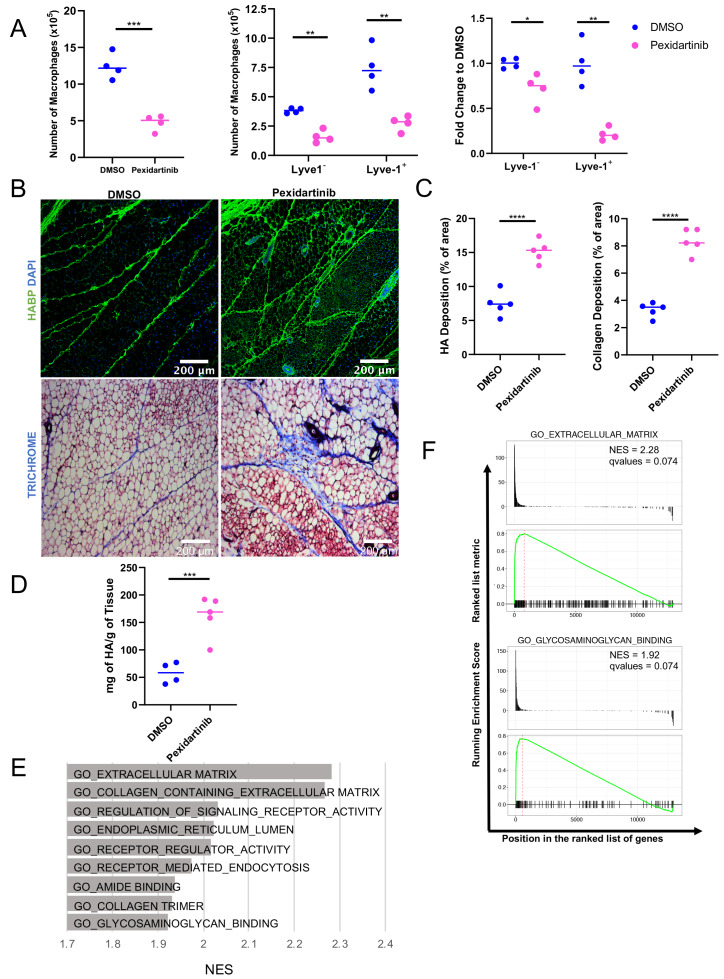
Macrophage depletion impacts ECM in the stroma.(A) 5-week-old female mice were treated with pexidartinib for 2 weeks and mammary glands were harvested for analysis of macrophages for CD45+CD11b+F4/80+ by flow cytometry. Flow cytometry demonstrated depletion of CD45+CD11b+F4/80+Lyve-1– and CD45+CD11b+F4/80+Lyve-1+ cells in the mammary gland following pexidartinib treatment. Quantification of total cell counts and fold-change depletion are shown. Total Macrophages Number DMSO vs pexidartinib, p=0.0007; Lyve1– Macrophages Number DMSO vs pexidartinib, p=0.0015; Lyve1+ Macrophages Number DMSO vs pexidartinib, p=0.0095; Lyve1– Fold Change DMSO vs pexidartinib, p=0.037; Lyve1+ Fold Change DMSO vs pexidartinib, p=0.0052. These data demonstrate one representative experiment, experiments were repeated three times with similar results, n = 4 mice per treatment group. (B) Mammary glands from mice treated with either pexidartinib or solvent control were stained for HA (HABP, green) or with trichrome to visualize collagen-containing ECM (collagen, blue). (C) Quantification of HABP and collagen staining. Between 3 and 6 images/sample were analyzed for HABP and collagen staining, n = 5 per treatment group. Three replicates were used for HABP analysis and one replicate was done for collagen analysis. HA deposition (% of area) DMSO vs pexidartinib, p<0.0001 (pooled) and collagen deposition (% of area) DMSO vs pexidartinib, p<0.0001. (D) Quantification of HA in mammary glands isolated from mice treated with pexidartinib or solvent control normalized to gland weight, p=0.0015, n = 4 mice for control group and n = 5 mice for pexidartinib group. (E) GSEA analysis of the C5 database for gene sets enriched in cluster 4 from the scRNA-seq analysis showing the top nine enriched gene sets by NES. (F) GSEA plots of representative lists identified in panel (E). *, p<0.05; **, p<0.01; ***, p<0.005; ****, p<0.0001; using Welch’s t-test.Figure 6—source data 1.Source data for graphs in panels A, C, and D.